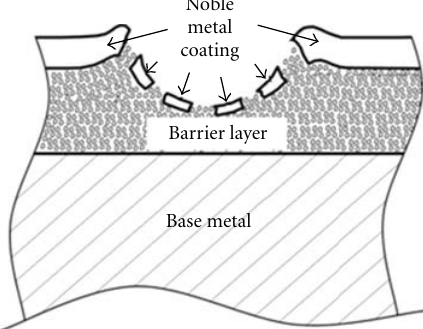
Figure 20: Wear pattern II partial wearing o ff of the upper layer and contact surface not totally covered with oxide.